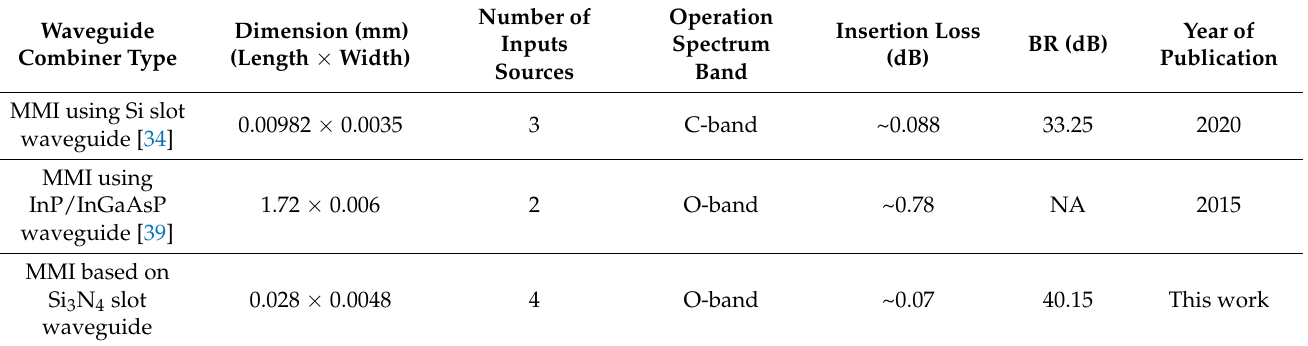
Table 1. Comparison between the key parameters of different waveguide power